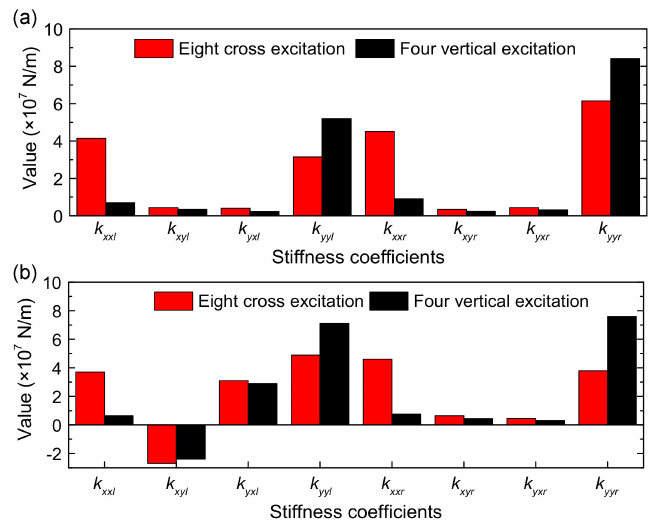
Figure 10. Bearing stiffness coefficients under two excitation methods: ( a ) 50 r/min; ( b ) 225